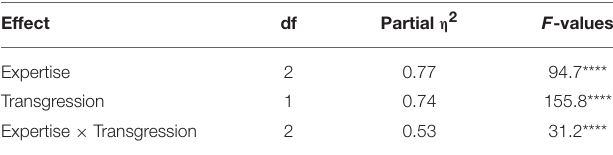
TABLE 2 | ANOVA results on d-prime: EX (3, inter) × T (2,